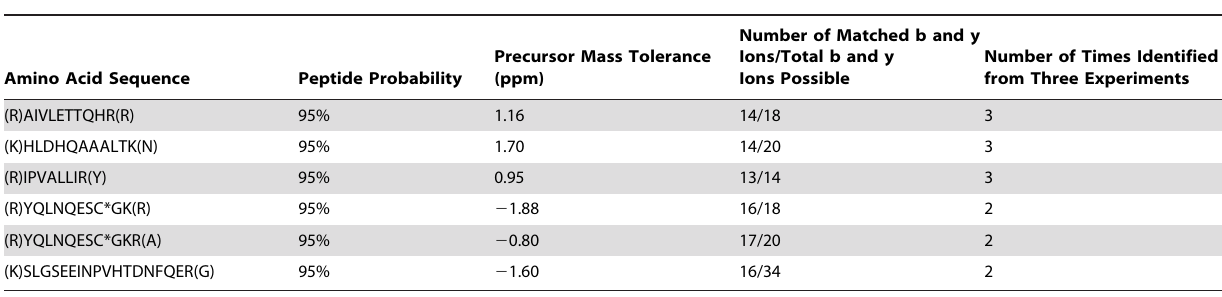
Table 1. Proteomic analysis of soluble proteins after iFGFR1